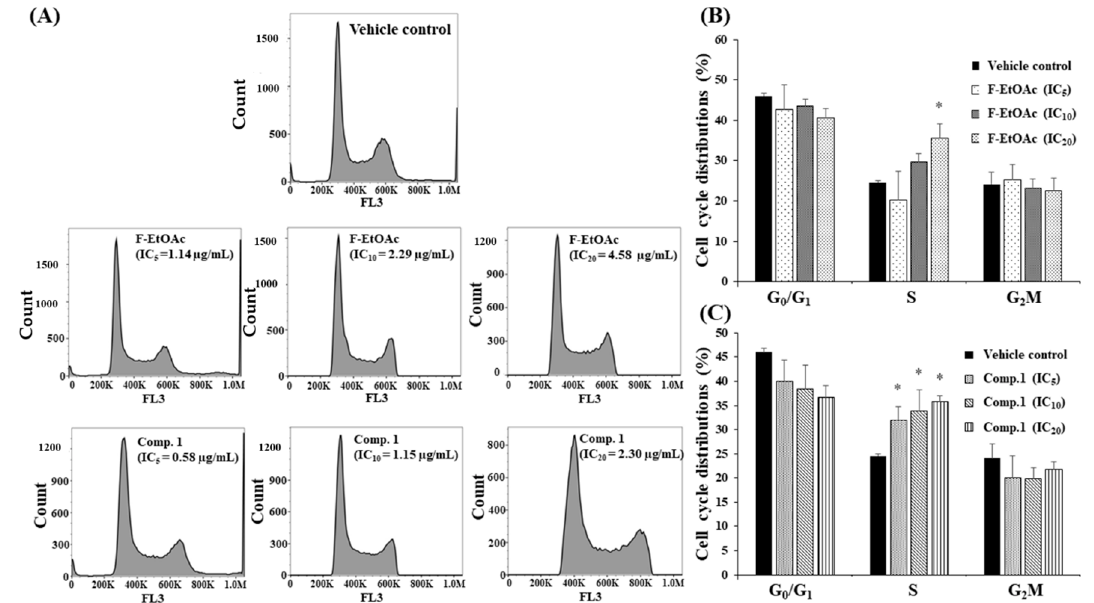
Figure 11. Cell cycle arrested following F-EtOAc and compound 1 treatments for 48 h. ( A ) KG-1a cells at the density of 1.5 × 10 5 cells/mL treated with F-EtOAc or compound 1 at various inhibition concentrations (IC) from IC 5 to IC 20 , and DMSO as vehicle control for 48 h. Cell cycle was analysed using flow cytometry. ( B ) Cell cycle distribution post F-EtOAc treatments. ( C ) Cell cycle distribution post compound 1 treatments. Data are expressed as mean ± SD of three independent experiments. Asterisks (*) denote significant differences from the vehicle control (* p < 0.05).